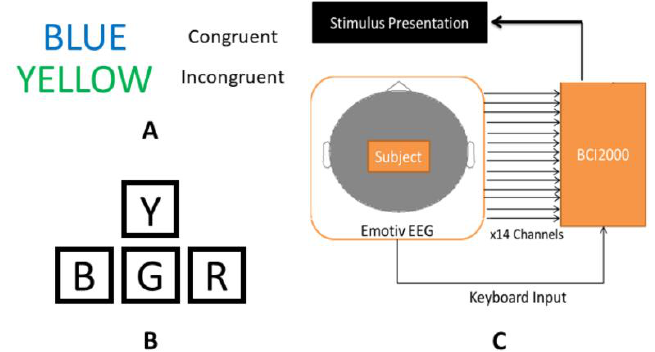
Figure 2. Experimental design components: examples of congruent and incongruent Stroop color–word stimuli ( A ); schematic of modified arrow keys on a standard keyboard, used to record subject responses to Stroop stimuli ( B ); and diagram of the hardware and software configuration used for data collection ( C ).